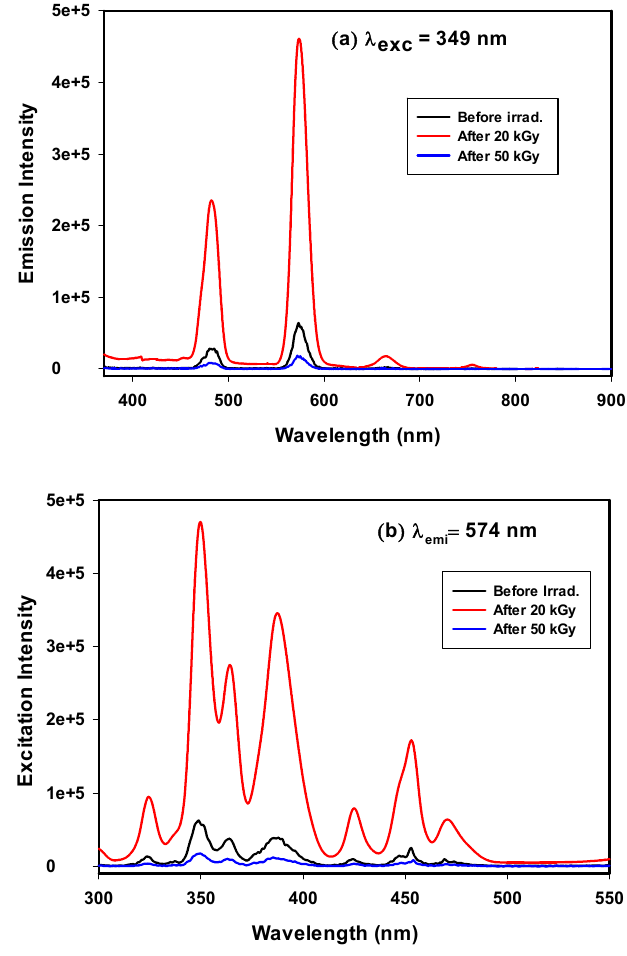
Figure 9. ( a ) Emission spectra and ( b ) Excitation spectra of GRN samples before and after gamma irradiated.